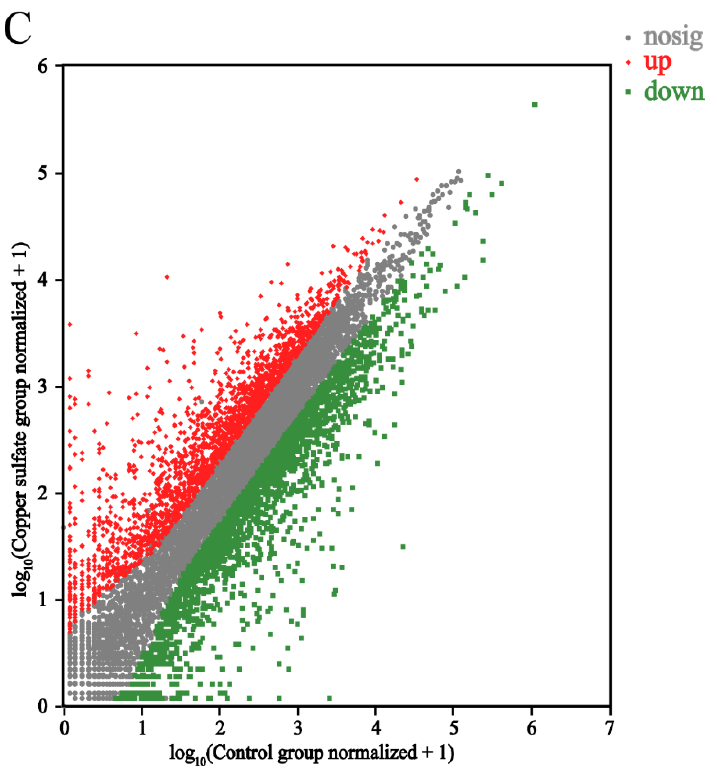
Figure 2. Scatter plots of gene expression in Saprolegnia parasitica following treatment with metalaxyl ( A ), bronopol ( B ) and copper sulfate ( C ). Gray dots indicate genes with no significant difference compared to the untreated control ( P adj < 0.05), green dots indicate significantly downregulated genes compared to the untreated control ( P adj < 0.05) and red dots indicate significantly upregulated genes ( P adj < 0.05) and log2FC of >2 compared to the untreated control, with numerical annotations to indicate the number of differentially expressed genes.